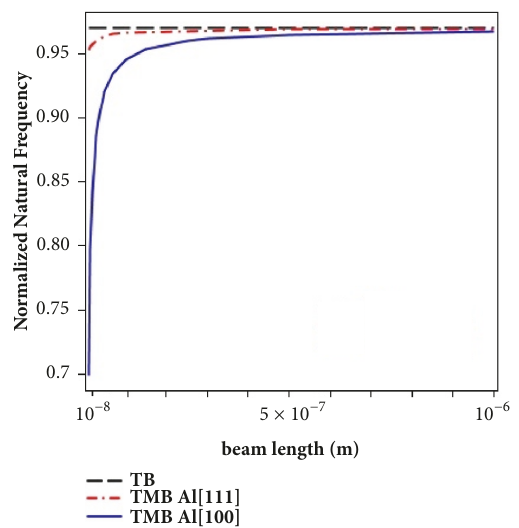
Figure 7: Influence of surface effects and size dependence on the normalized fundamental natural frequency of the microcantilever for 2h=0.2L, b=0.4L, and 𝜅 = 5/6